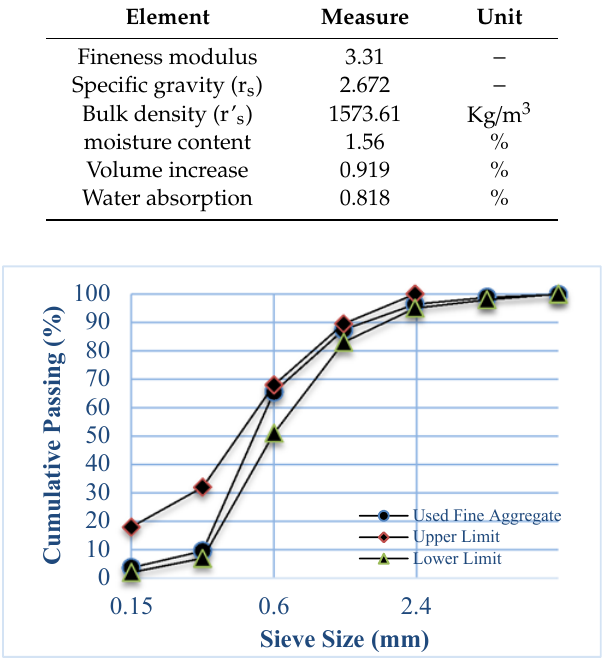
Figure 2. Particle size distribution (sieve analysis) for used fine aggregate.